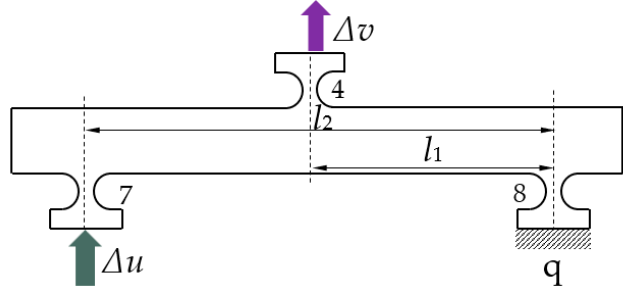
Figure 3. Schematic diagram of the lever working principle.